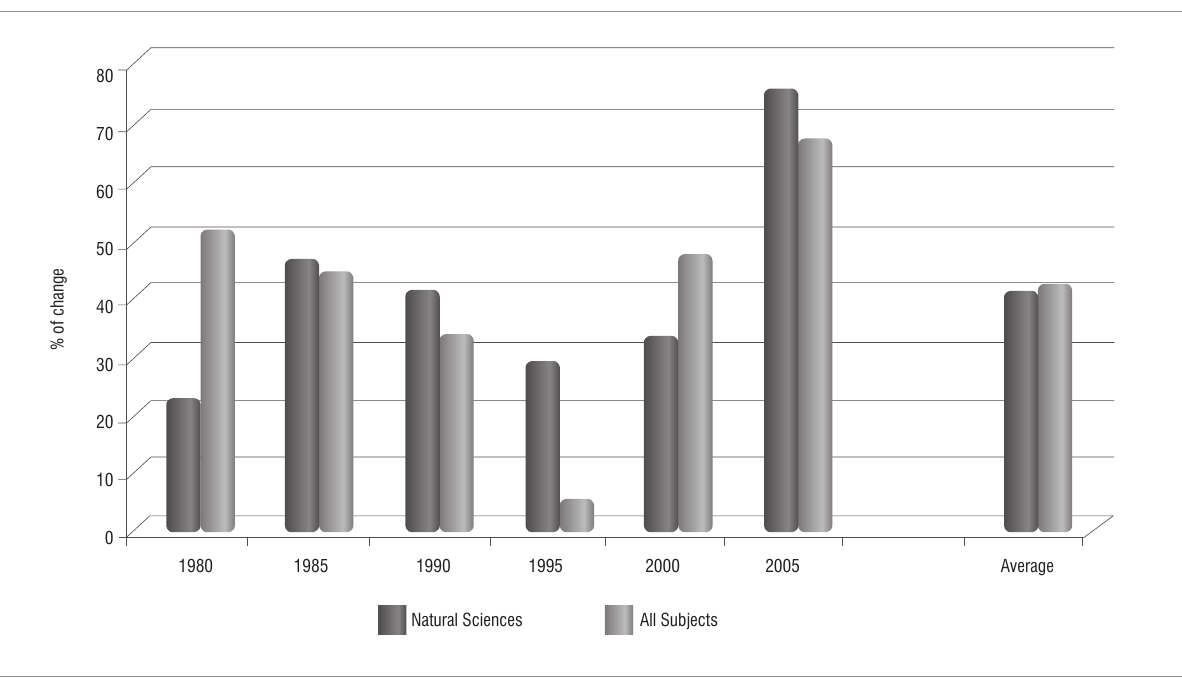
Figure 2: Year-on-year change in the production of publications in the natural sciences and in ‘all